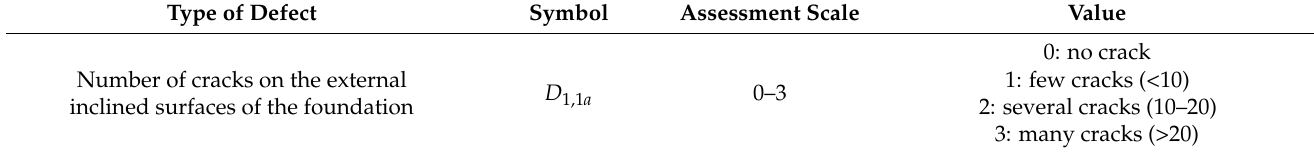
Table 1. Defects assessed on the gravity-based foundations.